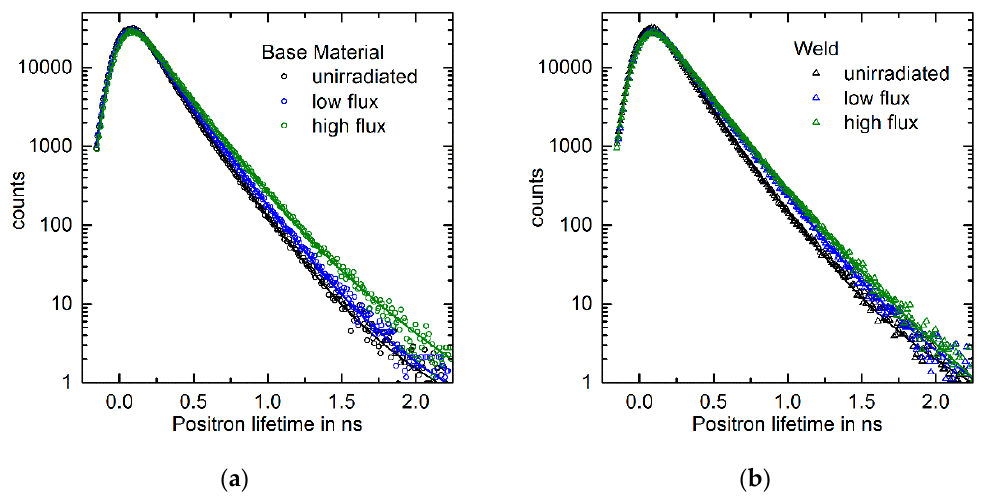
Figure 1. Measured lifetime spectra and fitted three-component models for ( a ) a low-flux (BL) and high-flux (BH) condition of the RPV base material, along with the unirradiated reference (BU); ( b ) a low-flux (WL) and high-flux (WH) condition of the RPV base material along with the unirradiated reference (WU).